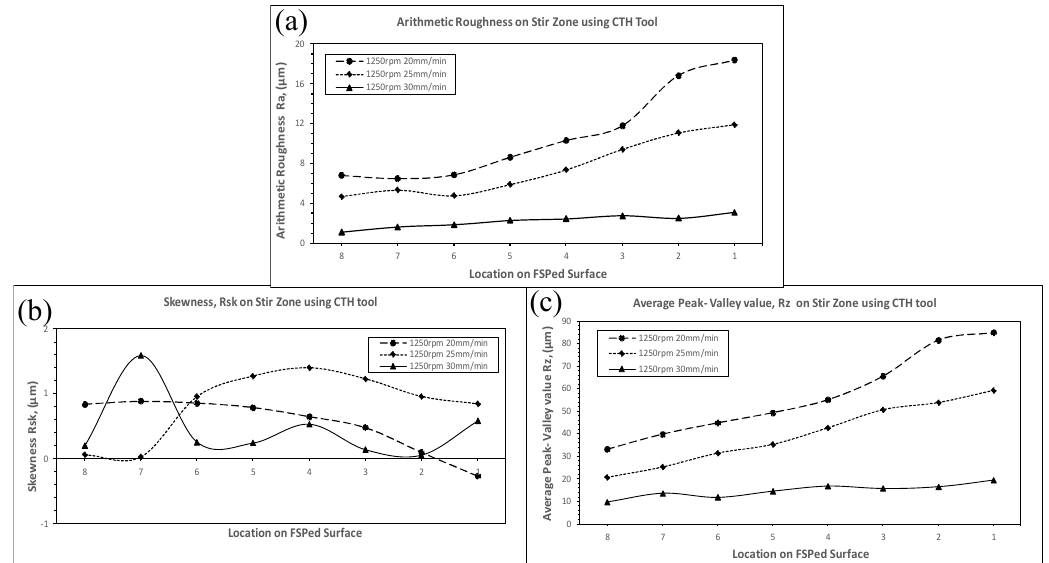
Figure 14. ( a ) Arithmetic roughness, Ra, ( b ) skewness, Rsk, and ( c ) average peak-valley, Rz, value for FSP using 1250 rpm and CTH tool at different feed rates. Table 2. Maximum arithmetic roughness (Ra), skewness (Rsk), and average peak-valley (Rz) values produced by different processing parameters with different FSP tool pin geometry.